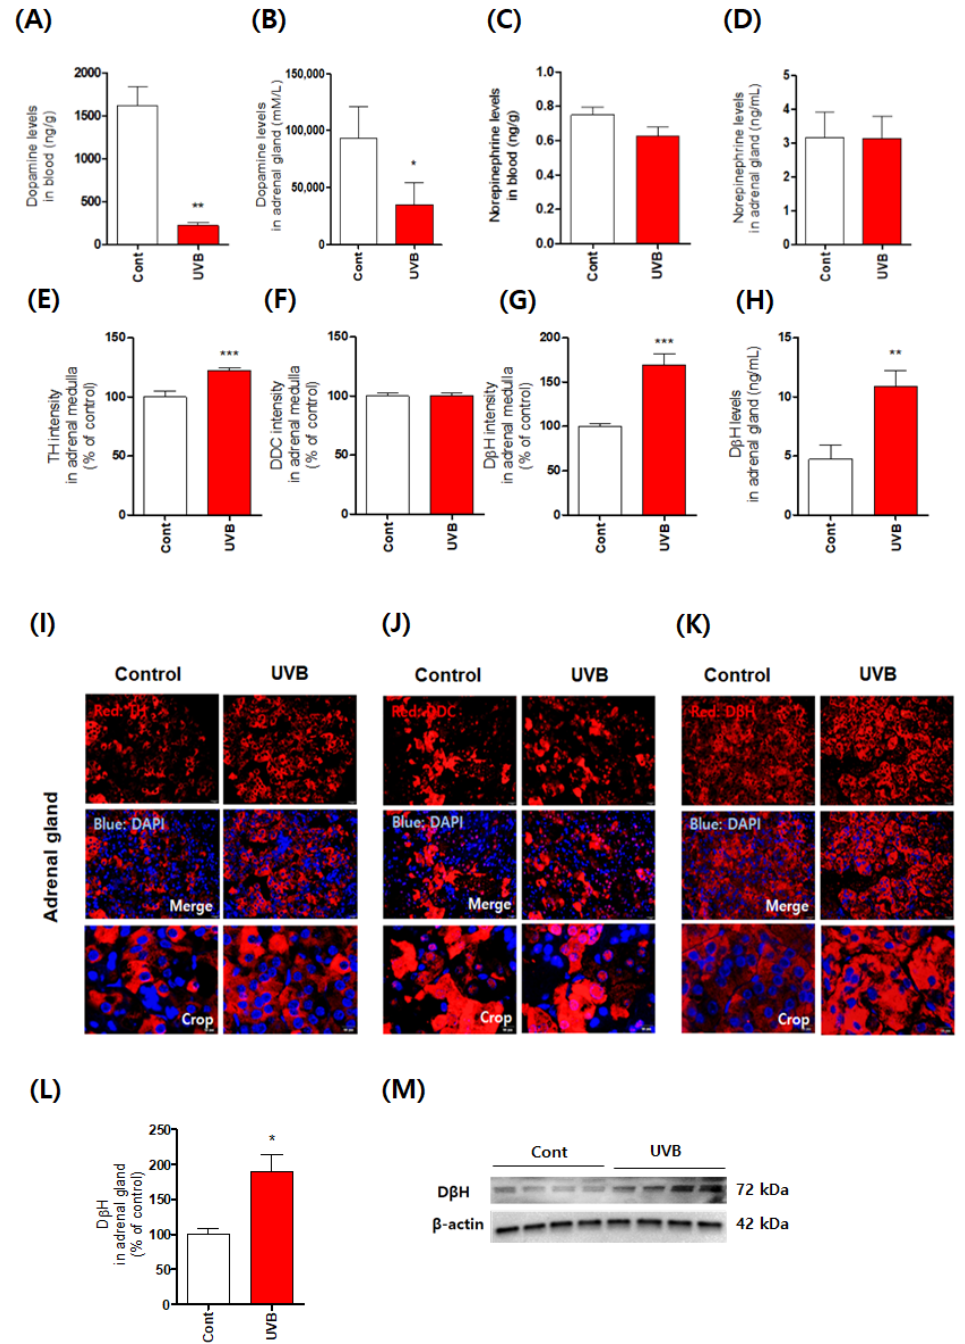
Figure 1. Acceleration of stress response via the upregulation of dopamine- β -hydroxylase (D β H) expression in the adrenal medulla caused by mouse skin exposure to chronic excessive UVB irradiation. Dopamine ( A , B ) and norepinephrine ( C , D ) levels in the blood and adrenal gland were quantified using ELISA kits and HPLC-ECD. The levels of the related enzymes, tyrosine hydroxylase (TH; ( E )), L-DOPA decarboxylase (DDC; ( F )), and dopamine β -hydroxylase (D β H; ( G )), were quantified by determining fluorescence intensity using immunohistochemistry. The levels of the D β H ( H ) were determined by ELISA. Representative photomicrographs are shown ( I – K ). D β H levels were also quantified using ELISA ( L ) and western blotting ( M ). Values represent the mean ± standard error of the mean. Statistical significance of differences is illustrated as follows: * p < 0.05, ** p < 0.01, and *** p < 0.001 compared with the control